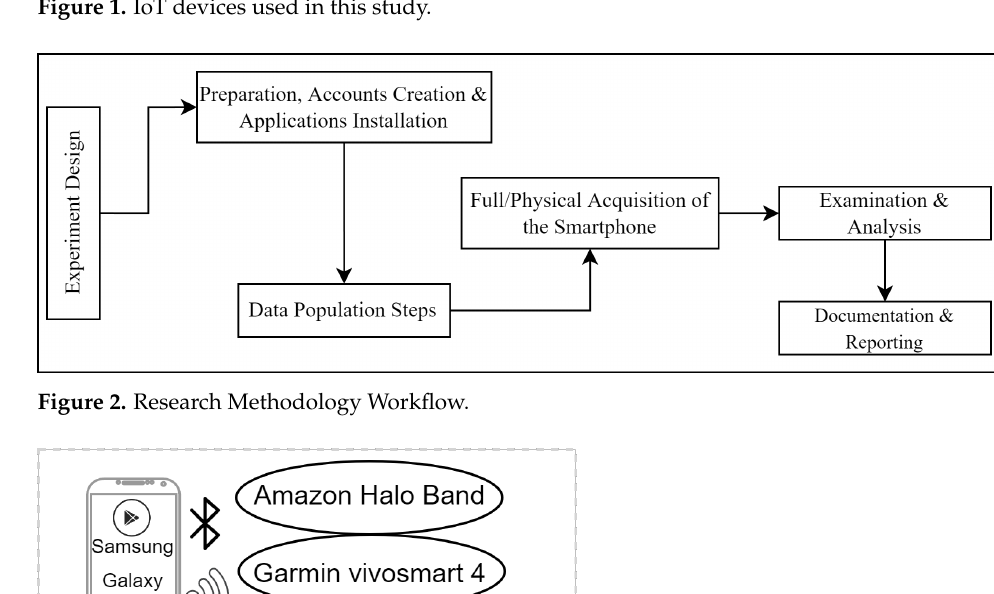
Figure 1. IoT devices used in this study.